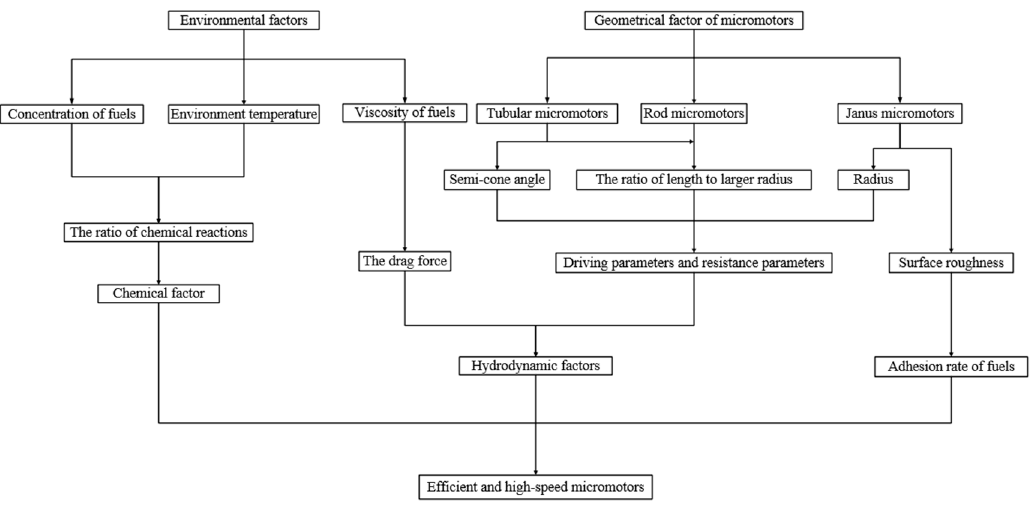
Figure 4 . Different factors affect the dynamic behavior and the efficiency of bubble-driven micromotors. The factors influencing the dynamic behavior of micromotors are divided into environmental factors and geometrical factors of micromotors. From another viewpoint, the factors could also be divided into chemical factors and hydrodynamic factors. The hydrodynamic factors consist of the size of micromotors and the viscosity of solution, and chemical factors mainly include the concentration of fuels and the environment temperature.